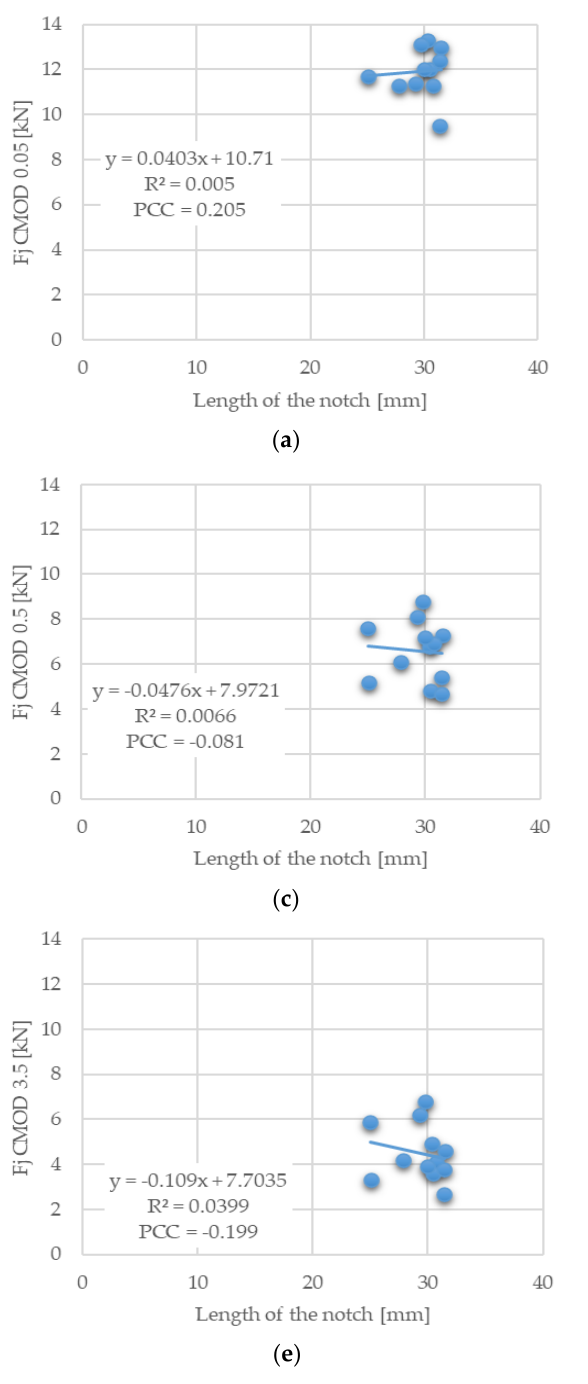
Figure 7. Length of the notch and load corresponding to CMOD 0.05 mm (limit of proportionality): fibre A ( a ), fibre B ( b ); CMOD 0.5 mm: fibre A ( c ), fibre B ( d ); CMOD 3.5 mm: fibre A ( e ), fibre B ( f